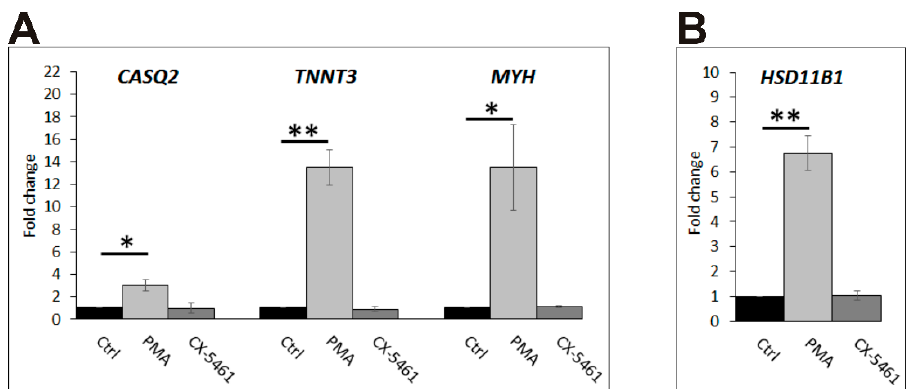
Figure 9. Relative mRNA expression of selected genes in MO3.13 cells. ( A ) Expression of CASQ2 , TNNT3 , and MYH ( various isoforms ). ( B ) Expression of HSD11B1 . Control cells (Ctrl—black bars); cells treated with PMA or CX-5461, grey and dark grey bars, respectively. ( n = 3) * p ≤ 0.05; ** p ≤ 0.01.